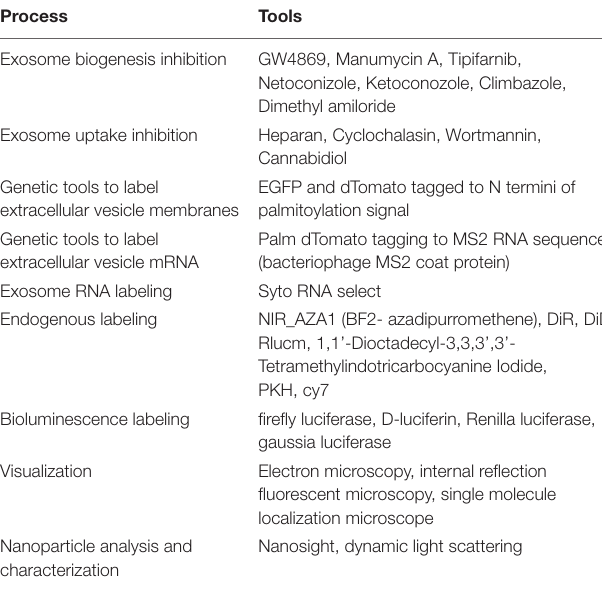
TABLE 1 | Common techniques and tools for understanding the biology of